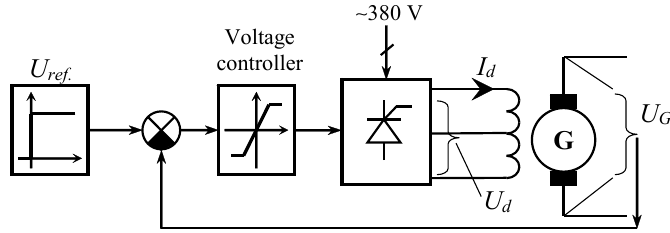
Figure 2. Functional scheme of the system for conducting the experiment.